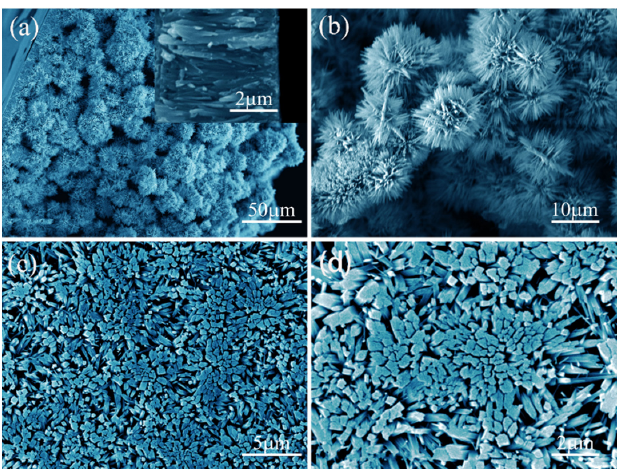
Figure 3. SEM images of TiO 2 nanoarrays grown on horizontally placed FTO substrate: ( a ) Front view of TiO 2 nanoarray; ( b ) A cross-sectional view and an enlarged view of the TiO 2 nanoarray; ( c ) TiO 2 nanoarray bottom view; ( d ) C magnified view.